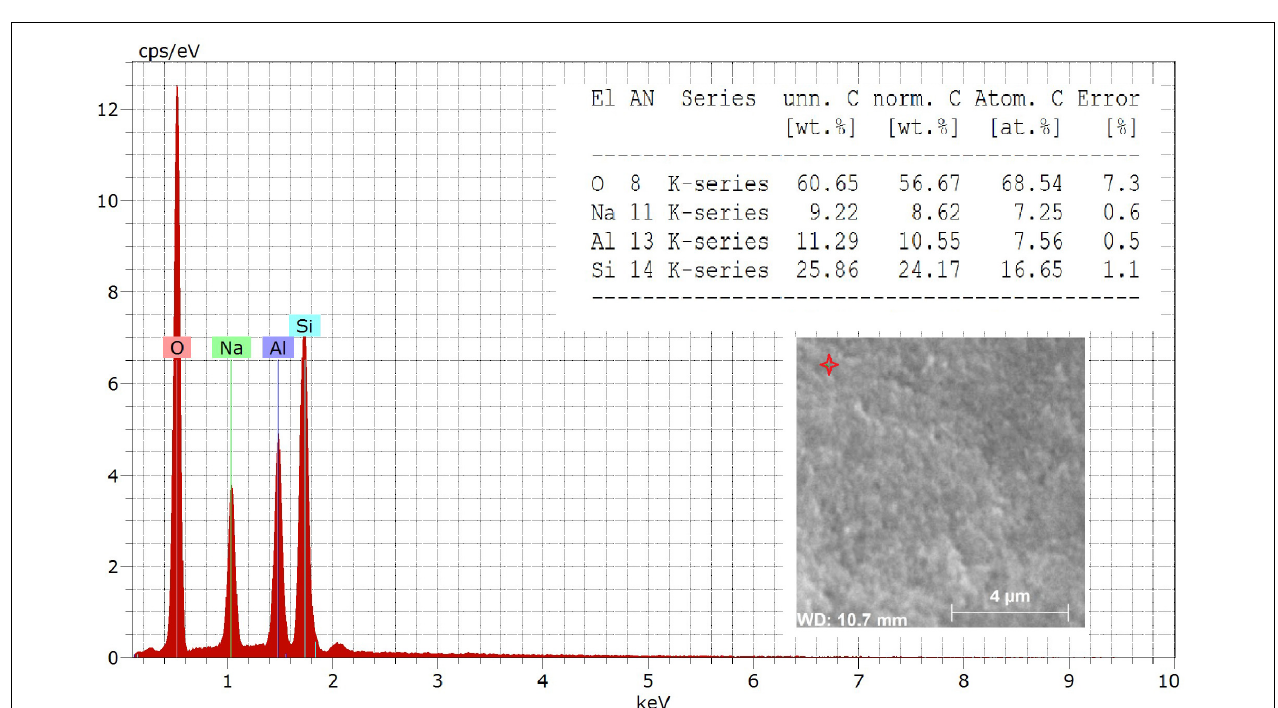
FIGURE 4 | SEM image of JGC, the jute fiber-geopolymer matrix (A) , the geopolymer matrix (B) , and the meso-pore network in the geopolymer matrix (C) .